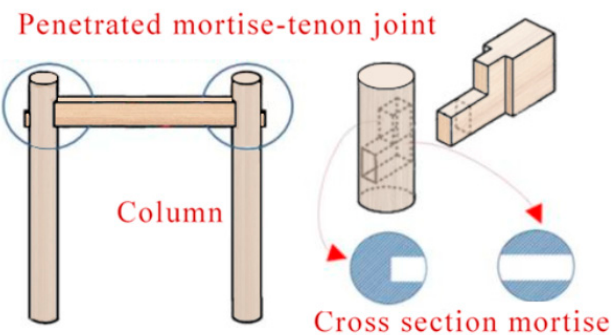
Figure 6. Constructions of PMT joint.